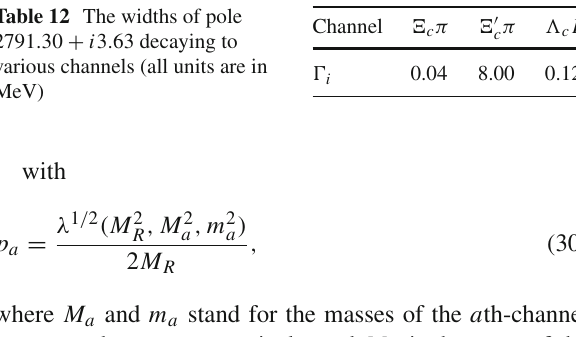
forthepoleat2191.30 + i 3.63MeVinthe J P = 1 / 2 − sectorwith q max = 700MeV i